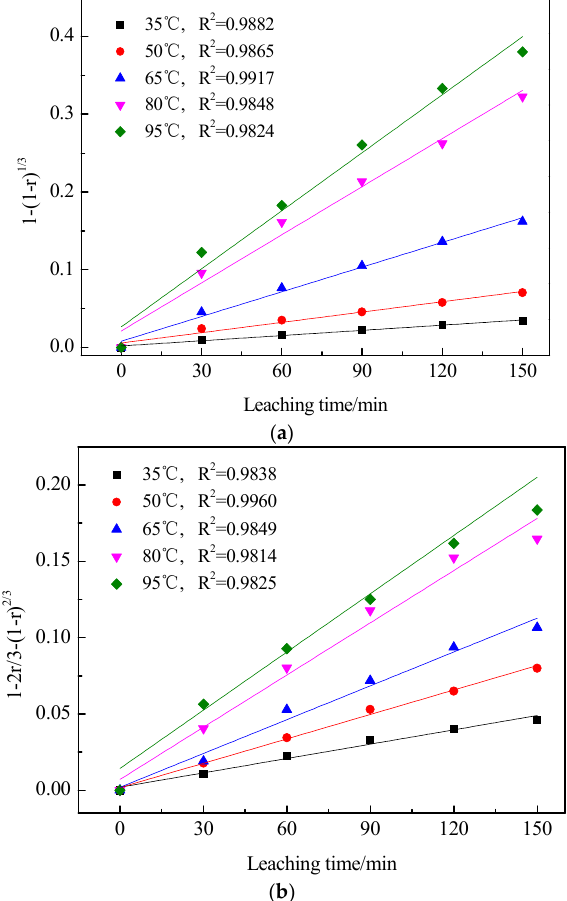
Figure 11. Plots of equation versus time at different leaching temperatures. ( a ) Blank roasting clinker; ( b ) Calcified roasting clinker.